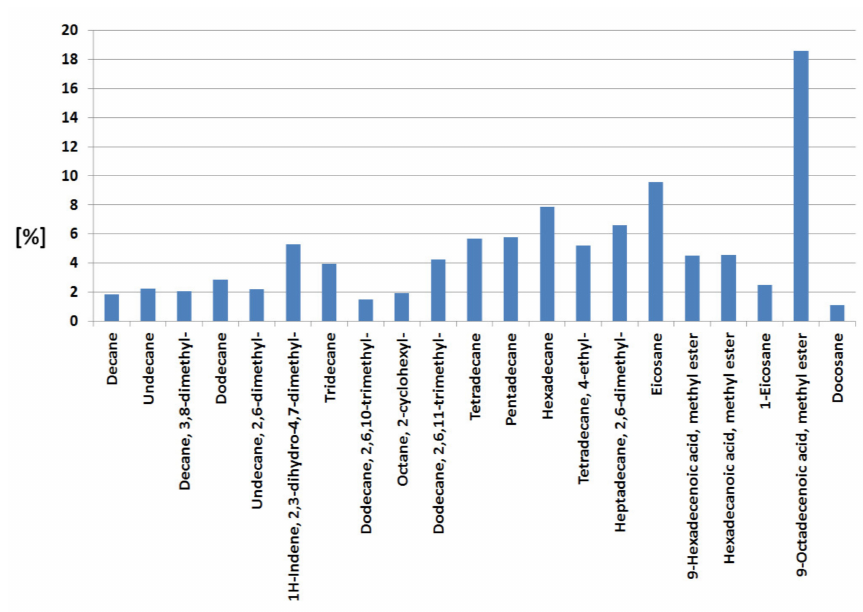
Figure 2. Chemical content of pure diesel supplied to the combustion engine studied.